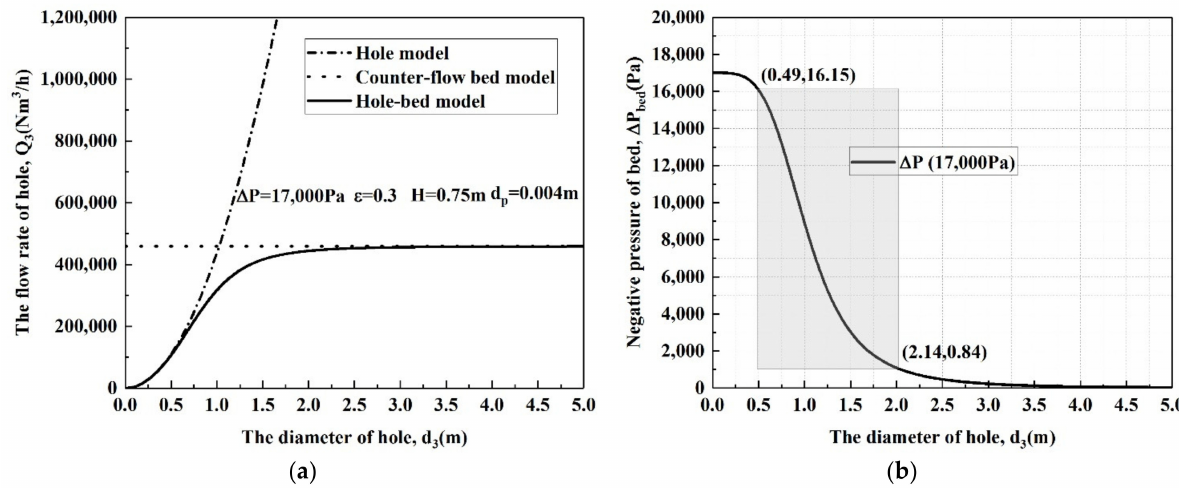
Figure 7. The results of the hole–bed model. ( a ) Variation in the leakage flow rate as a function of hole diameter. ( b ) Variation in bed negative pressure as a function of hole